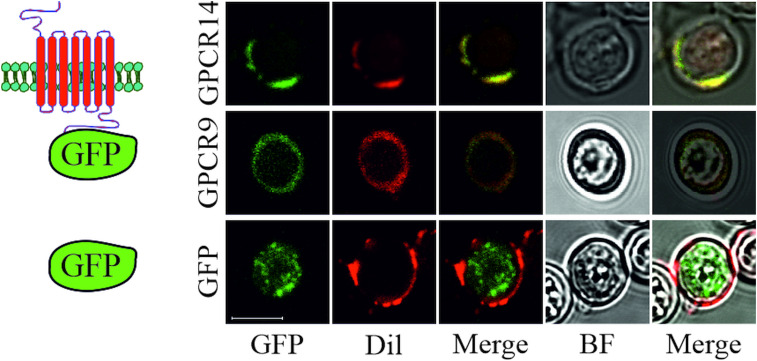
Subcellular localization of S. mansoni GPCRs in S. cerevisiae. Plasmids coding for eGFP or GPCRs (Smp_203500 (GPCR14) and Smp_244240opt (GPCR9)) tagged with eGFP at the C-terminus were transformed into yeast strain Y178. Fluorescence of eGFP and the membrane-stain Dil were recorded by CLSM. Fluorescent images were merged individually or with bright field (BF) images, respectively. Scale bar, a representative for all pictures: 5 μm.